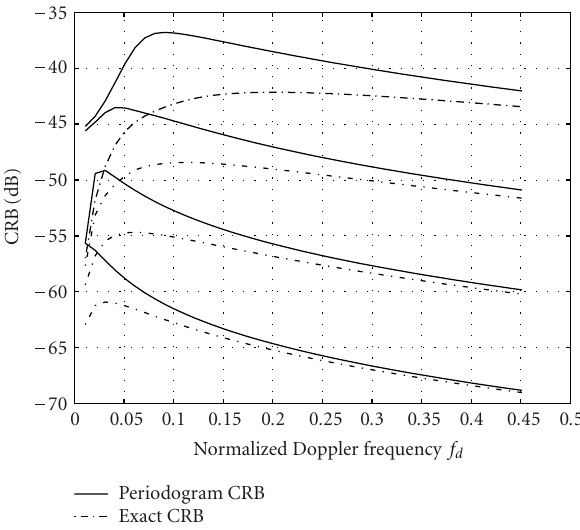
Figure 5: The asymptotic CRB with respect to N . The results shown are for di ff erent values of f d = 0 . 001,0 . 003,0 . 005,0 . 011 from top to bottom and κ = 100. β =